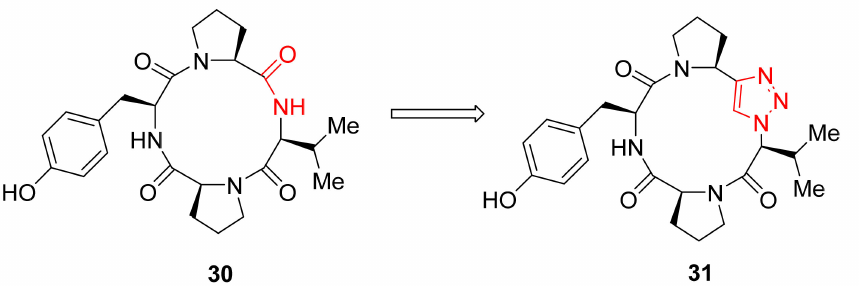
Figure 13. Substitution of the amide bond in the natural product 30 with 1,4-triazole. Mitochondrial proteins, Smac and Smac mimetics, such as 32 (Figure 14), inhibit apoptosis and are therefore important anticancer agents. Wang et al. replaced the two amide bonds of 32 with two triazoles in an attempt to improve cell activity and reduce peptide characteristics